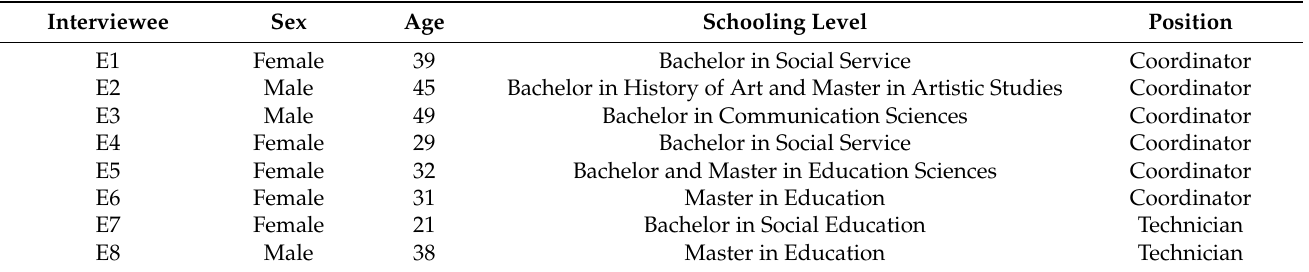
Table 1. Sociodemographic and professional characteristics of professionals in the Escolhas